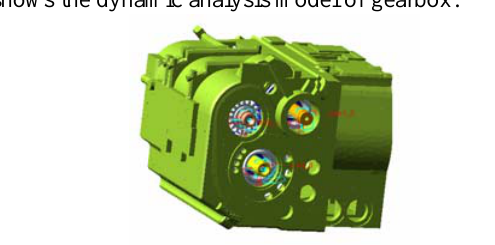
Fig.12. analysis model of gearbox